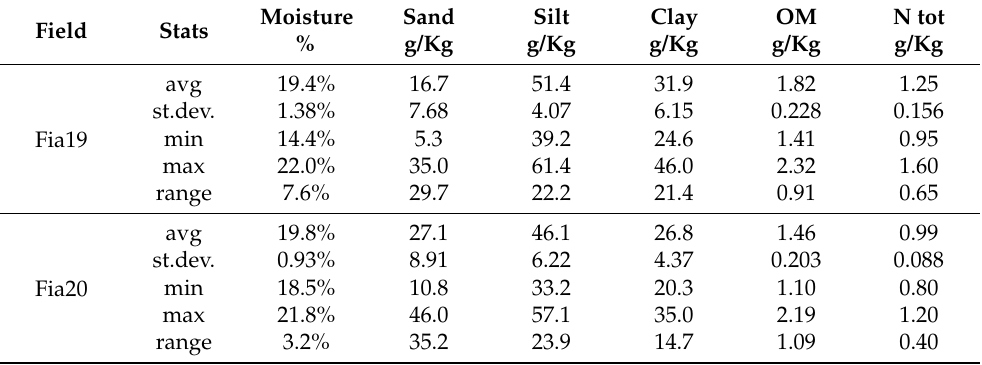
Table 3. Main soil sampling statistics for Fia19 and Fia20